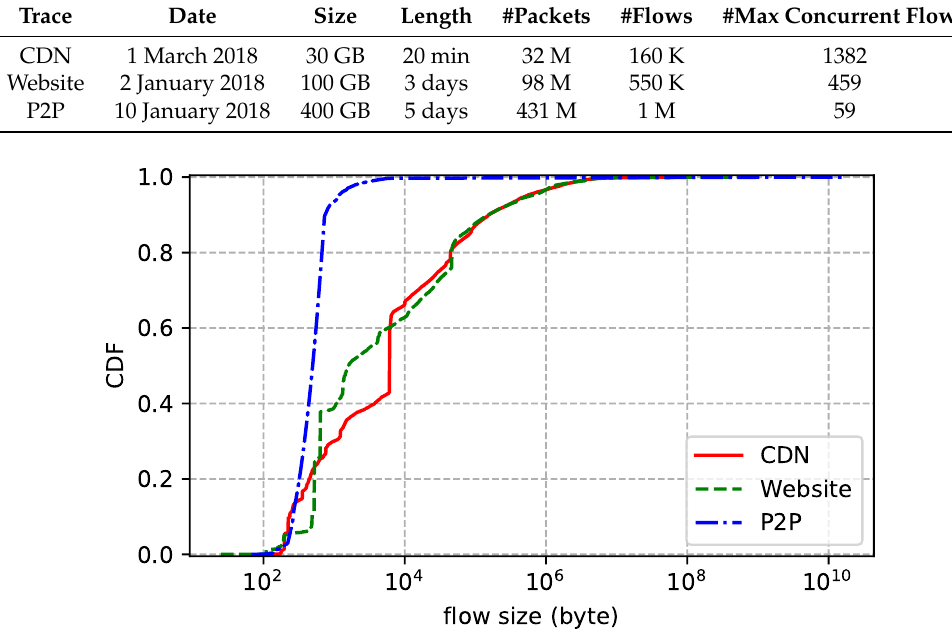
Figure 2. Flow size distribution of each